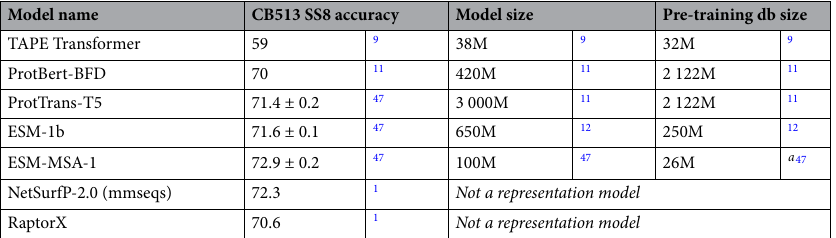
Table 1. Overview from literature of the best performing protein representation models on the secondary structure prediction task for 8 classes (SS8), using the CB513 dataset. We have gathered results from three articles that report model performance(s) on the CB513 dataset. The performance metric shown here is percent SS8 accuracy as reported. NetSurfP-2.0 and RaptorX models from Klausen et al. 1 are included as examples of state-of-the-art performance (neither of these are based on protein representation models). The other methods are all represenation models, and only the MSA Transformer (ESM-MSA-1) achieves higher accuracy than NetSurfP-2.0. The number of parameters (model size), the number of sequences in the pre- a training dataset, and corresponding references are also reported. Rao et al. 47 create one MSA per sequence as input for ESM-MSA-1, which means pre-training was performed on the same number of sequences as